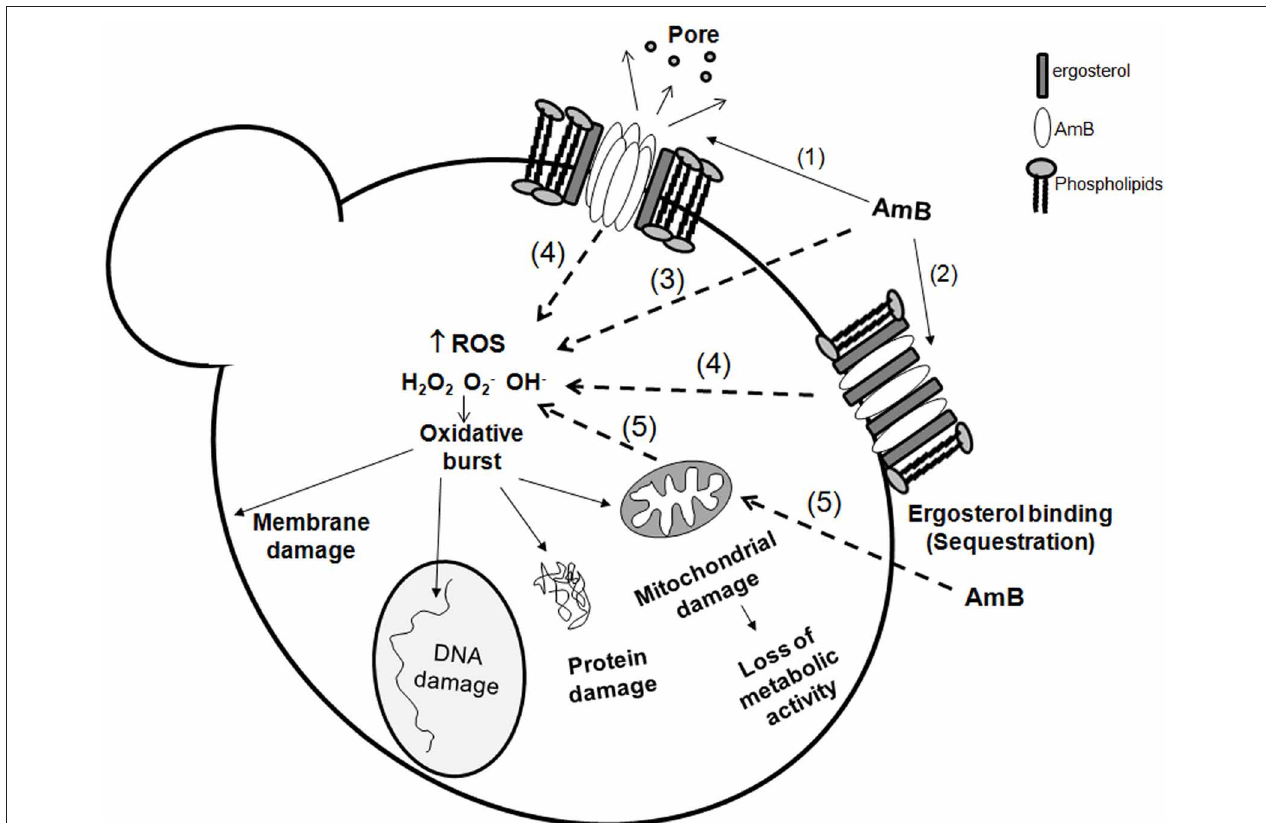
FIGURE 1 | Amphotericin B action mechanisms on fungal cells. Amphotericin B exerts its action at different levels on the cell: membrane effects and intracellular effects. At the membrane, it can bind to ergosterol (1) and form pores, or merely induce ergosterol sequestration (2) resulting in membrane stability disruption. In the cell, AmB also induces an oxidative burst. The mechanism of this induction remains unknown, but there are several possibilities: AmB can act directly as a prooxidant (3) and induce